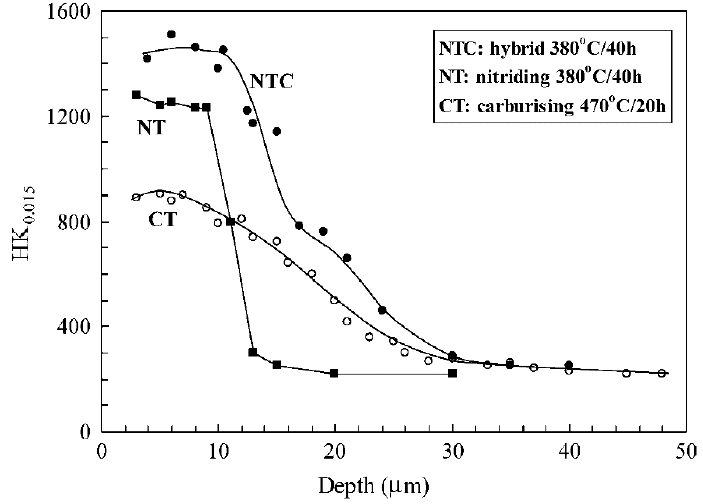
Figure 8. Microhardness profiles of AISI 321 samples plasma nitrided (380 °C, 40 h), carburized (470 °C, 20 h) and nitrocarburized (NTC hybrid process) (380 °C, 40 h). For further details, see [60]. (Reprinted from Materials Science and Engineering A, 404, Y. Sun, Hybrid plasma surface alloying of